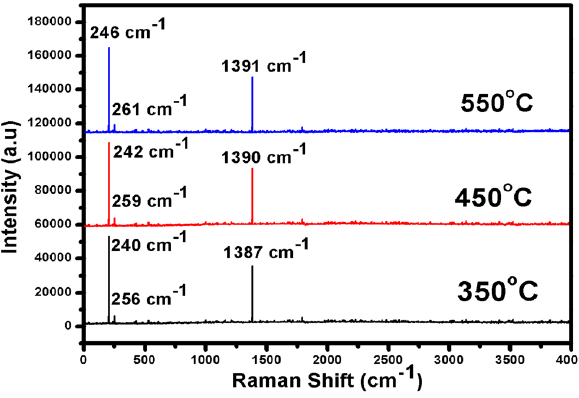
Figure 4: Raman spectra of the prepared CuO samples calcinated at 350, 450,